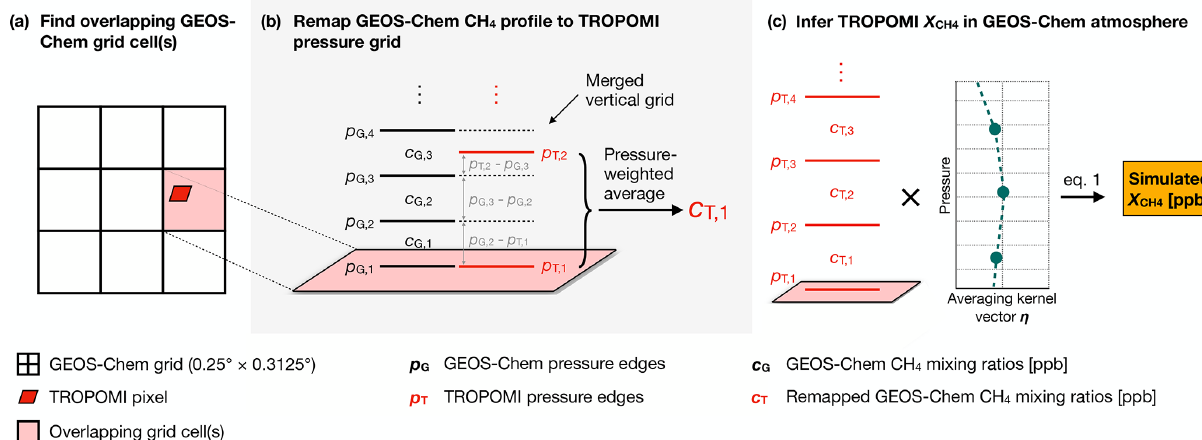
Figure 2. Simulation of TROPOMI column-average dry-air mixing ratio ( X CH ) observations in the GEOS-Chem 3-D model atmosphere. 4 (a) The operator first identifies which GEOS-Chem grid cells overlap with the TROPOMI observation pixel. (b) The operator remaps conservatively the GEOS-Chem vertical profile of methane dry sub-column mixing ratios c G from the GEOS-Chem pressure grid p G to the TROPOMI pressure grid p T to produce a vertical profile of methane sub-column mixing ratios c T on the TROPOMI pressure grid. (c) The TROPOMI averaging kernel vector η (Eq. 1) is applied to the remapped GEOS-Chem profile on the TROPOMI pressure grid to produce a virtual X CH observation of the GEOS-Chem atmosphere. If multiple GEOS-Chem grid cells overlap with the TROPOMI observation, the 4 corresponding X CH values are area-weighted to the TROPOMI 4